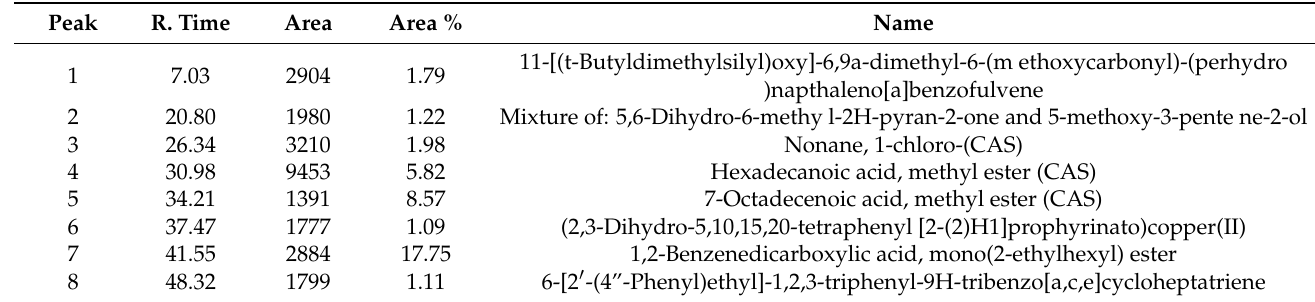
Table 4. GC–MS analysis of R. damascena callus in the L-ascorbic acid